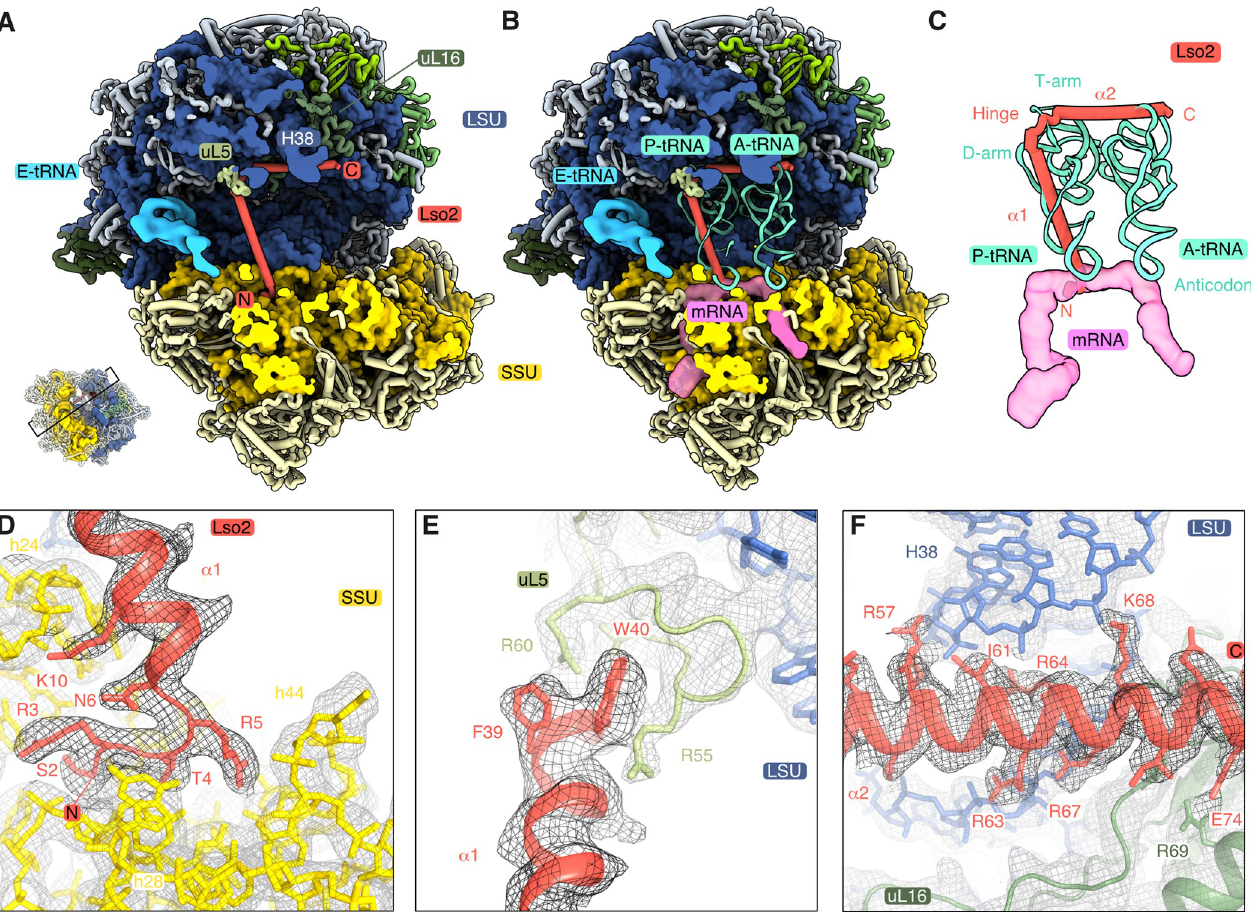
Fig 2. Microsporidian Lso2 interactions with the ribosome. (A) Slab view of Lso2 (red) bound ribosomes along with the cryo-EM density for E-site tRNA (sky blue). Lso2 ends contacting the SSU and LSU are indicated as N and C, respectively (PDB 6ZU5). (B) Lso2 prevents tRNA and mRNA binding in the A- and P- site as shown by the superimposed tRNAs (aquamarine, from PDB 4V6F) and an mRNA (pink surface, from PDB 4V6F). (C) An isolated view of Lso2 sterically blocking the codon–anticodon site, as well as the D- and T-arm of the P-site tRNA. The C-terminal end overlaps with the T-arm of the A-site tRNA. (D–F) Molecular contacts between Lso2 and the ribosome, shown as cryo-EM density (mesh) and the structural model. Lso2 residues contacting the rRNA or ribosomal proteins are indicated. A-site, acceptor site; A-tRNA, acceptor site tRNA; C, C-terminus; cryo-EM, cryo–electron microscopy; E-site; exit site; E- tRNA, exit site tRNA; LSU, large subunit; N, N-terminus; P-site, peptidyl site; P-tRNA, peptidyl site tRNA; SSU, small subunit.